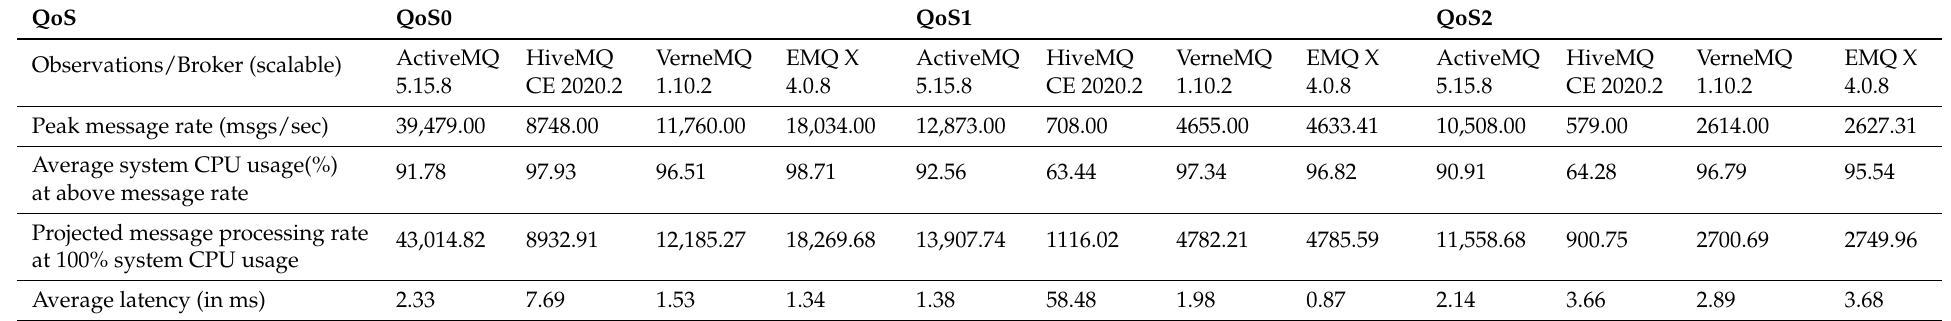
Table 8. Projected message processing rates of scalable brokers at 100% system CPU usage (local test results). All the brokers listed in this table are scalable in nature and can use all cores available in the system.